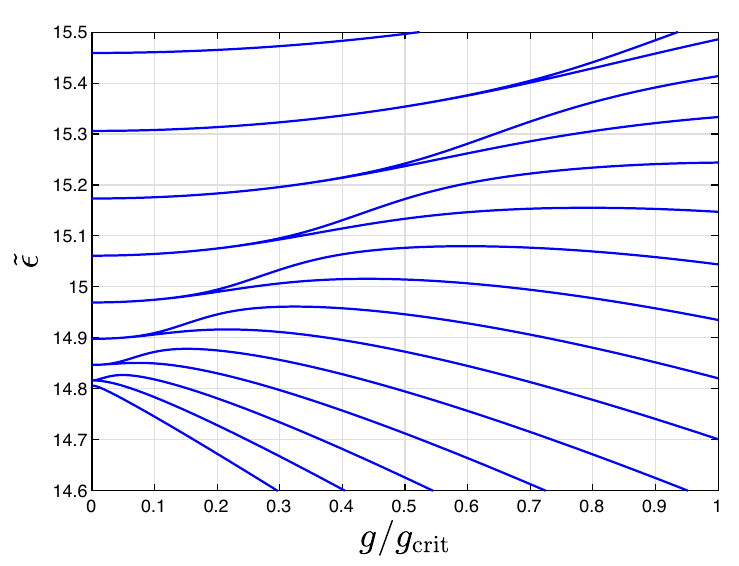
ε (α 1 α 2 )ε/(� α 2 N ) 2 of the Hamiltonian (1) (with ˜ = + + 50 and 14 , α 2 /α 1 1.5 , N = = =